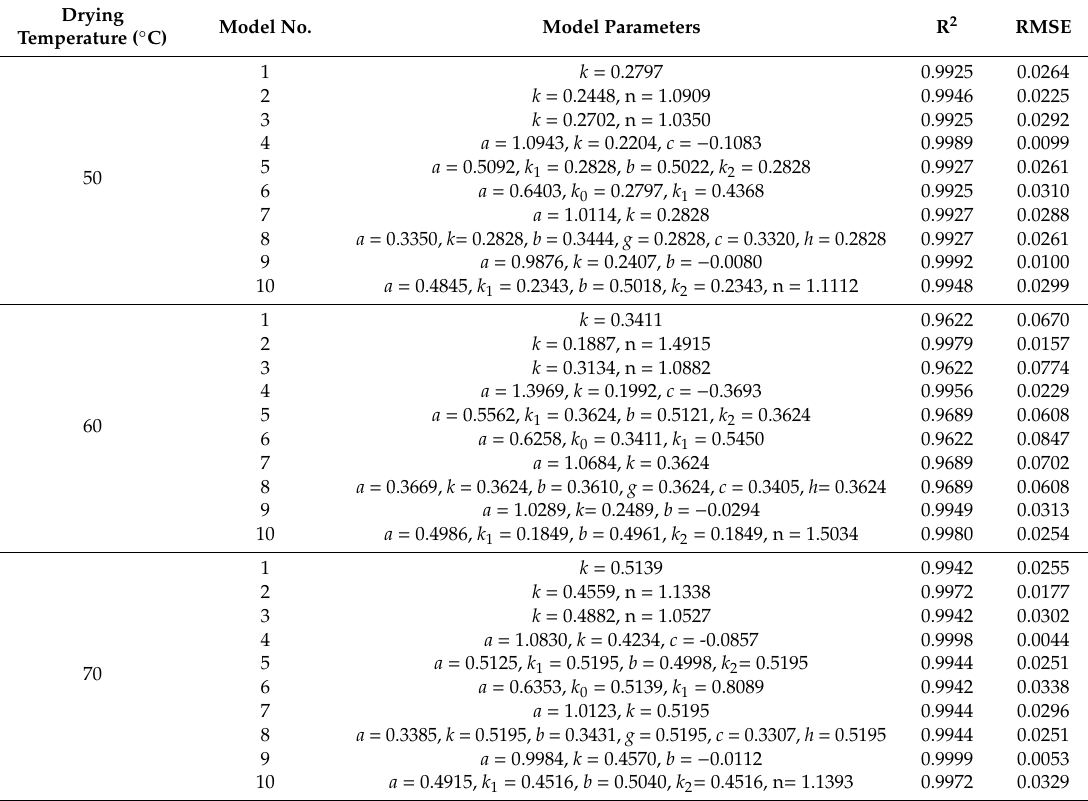
Table 7. Statistical evaluation of the mathematical drying models for persimmon samples of 8 mm thickness for